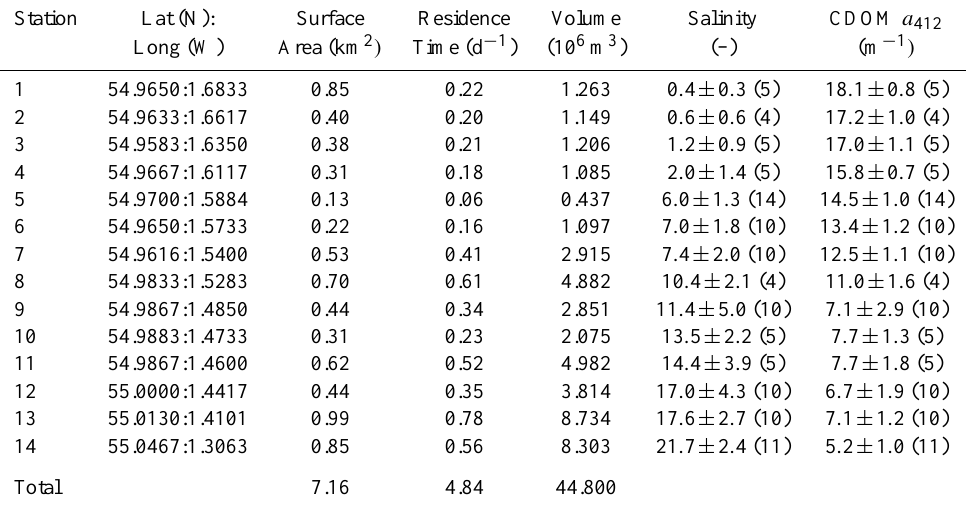
Table 1. Tyne estuary station numbers, geographical coordinates, surface areas, residence times, volumes, mean annual salinity and mean annual coloured dissolved organic matter absorption coefficient at 412nm. Standard errors are reported for salinity and CDOM a 412 data, together with sampling number, n , reported in parenthesis. Data were collected during 11 transects of the Tyne estuary which took place between November 1998 and April